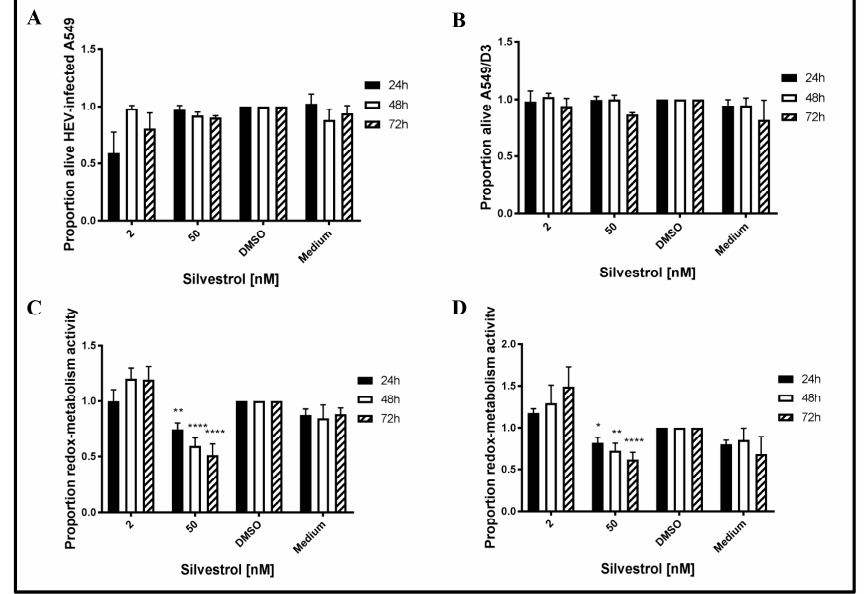
Figure 2. Lactate dehydrogenase (LDH) and PrestoBlue assays to determine silvestrol-mediated cytotoxicity and cytostaticity. ( A , B ) Processed data for LDH-activity in cell-culture supernatants derived from cells treated with 2 or 50 nM silvestrol as compared to respective DMSO controls in ( A ) A549 cells persistently infected with HEV strain 48932c or ( B ) in non-infected A549/D3. ( C , D ) Processed data for redox-metabolic activity in cells treated with 2 or 50 nM silvestrol when compared to respective DMSO controls in ( C ) A549 cells persistently infected with HEV strain 47832c or ( D ) in non-infected A549/D3 cells. * p < 0.05, ** p < 0.01, **** p <